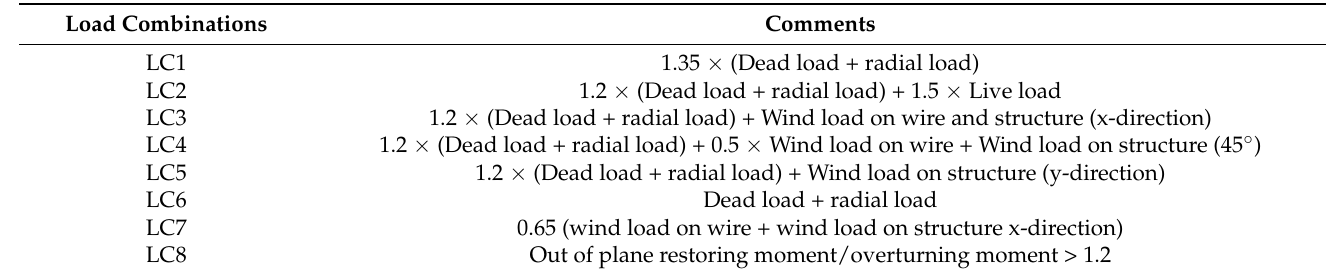
Table 2. Load combinations of OWS